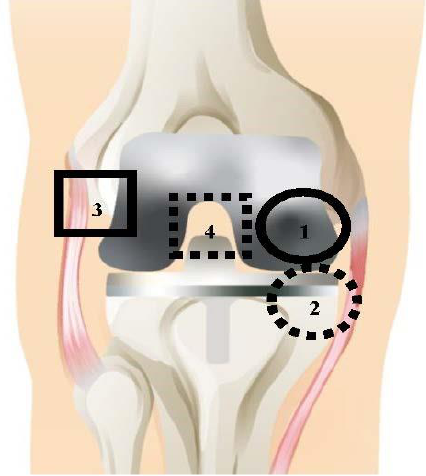
Figure 1. Map of approximate tissue collection locations, shown with prosthetic implant. Seven tissue samples were taken for each patient; (1) the solid circle represents the medial femoral condyle (denoted as F); (2) the dashed circle represents the medial tibial plateau (denoted as T); (3) the solid square represents the lateral gutter (denoted as LG); (4) the dashed square represents the posterior capsule (denoted as PC). Locations 1–4 were taken for the ATL layer, and locations 1–3 were taken for the RTL layer; separation between ATL (unhealthy tissue, closer to joint) and RTL (healthy tissue, further from joint) was approximately 1 cm, depending on individual patient.